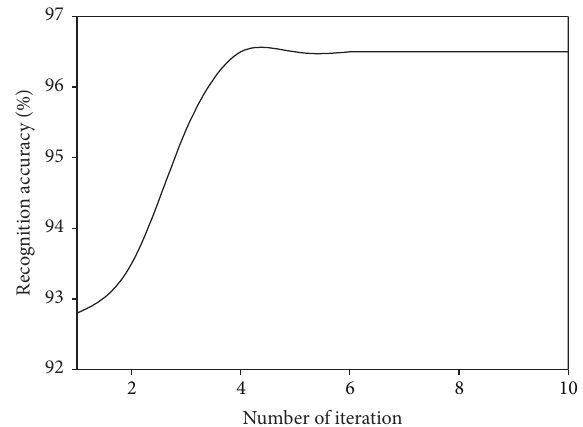
Figure 12: Recognition accuracy of MDGPP versus varying param- eter 𝜆 on the JAFFE database.